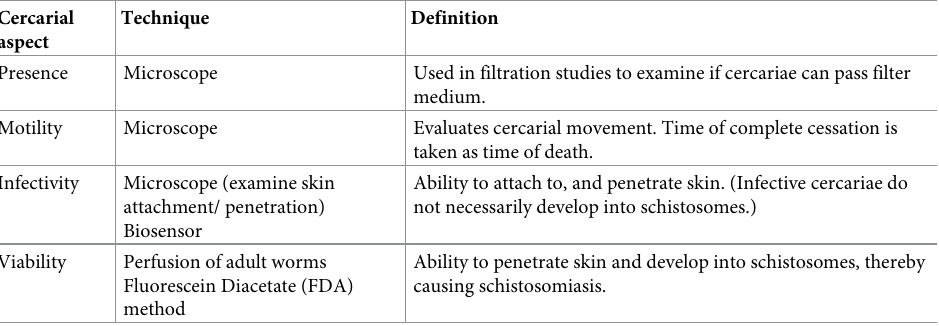
Table 2. Summary of methods used to assess the effectiveness of water treatment